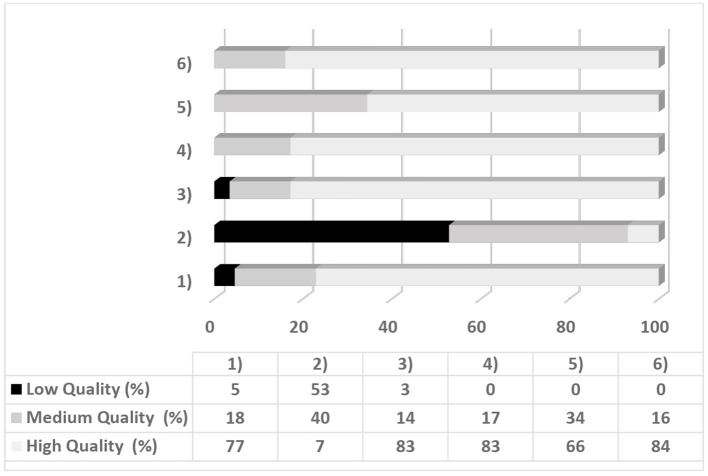
Percentage of the studies and quality levels for each point of tool assessment.